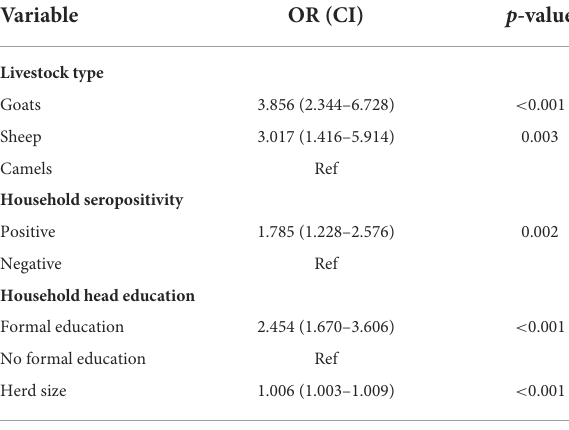
TABLE 3 Herd-level factors associated with brucellosis seropositivity.